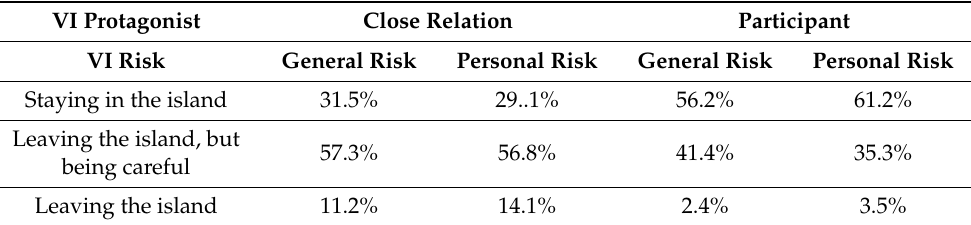
Table 1. Qualitative response to the scenario in each condition.